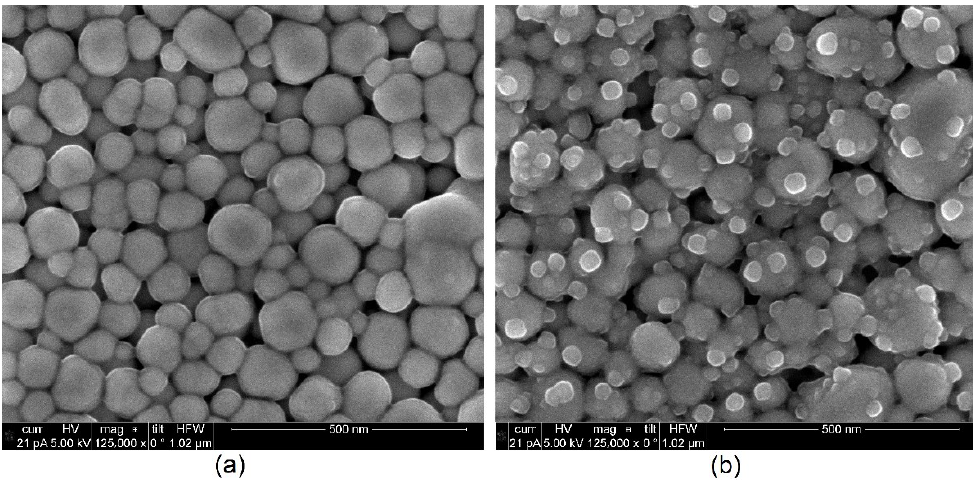
Figure 12. SEM images of silver nanoparticles, sintered with different energies. ( a ) 120 °C, 1 h with a heating rate of 2 K/min. ( b ) 200 °C, 24 h with a heating rate of 2 K/min.